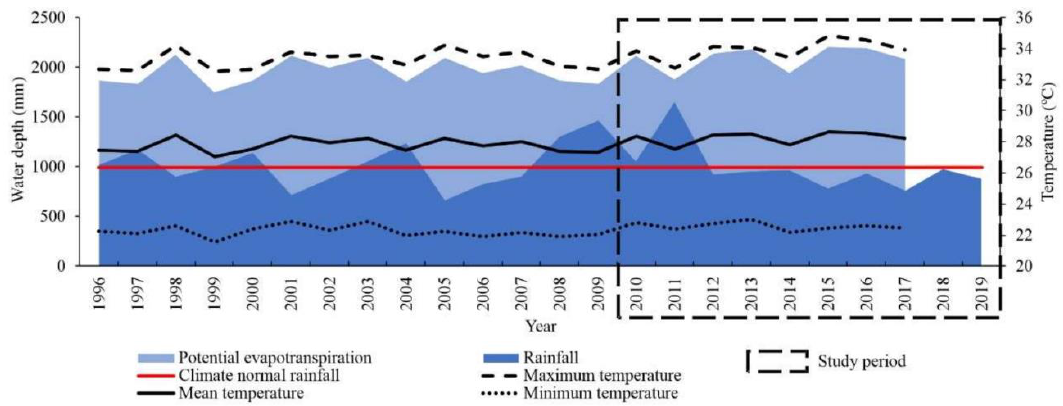
Figure 2. Distribution of climate variables in the district of Iguatu, Ceará, Brazil.